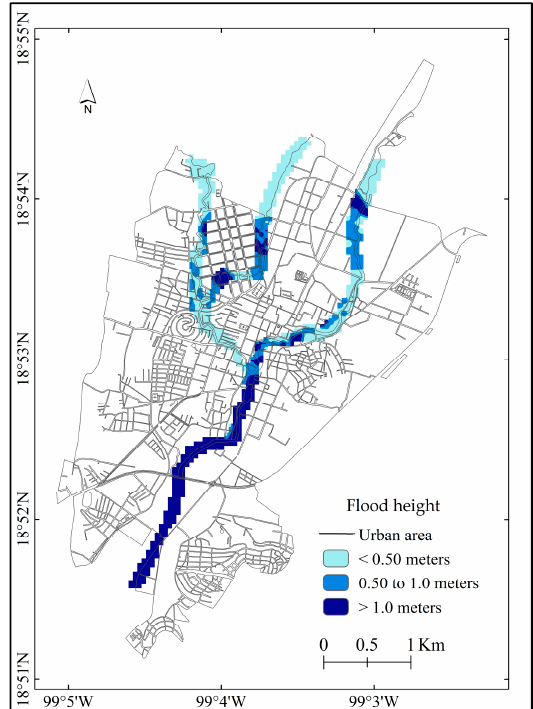
Figure 4. Hydrological hazard map for Rp = 50 years due to overflow of the Yautepec, Oacalco, and Apanquetzalco rivers.